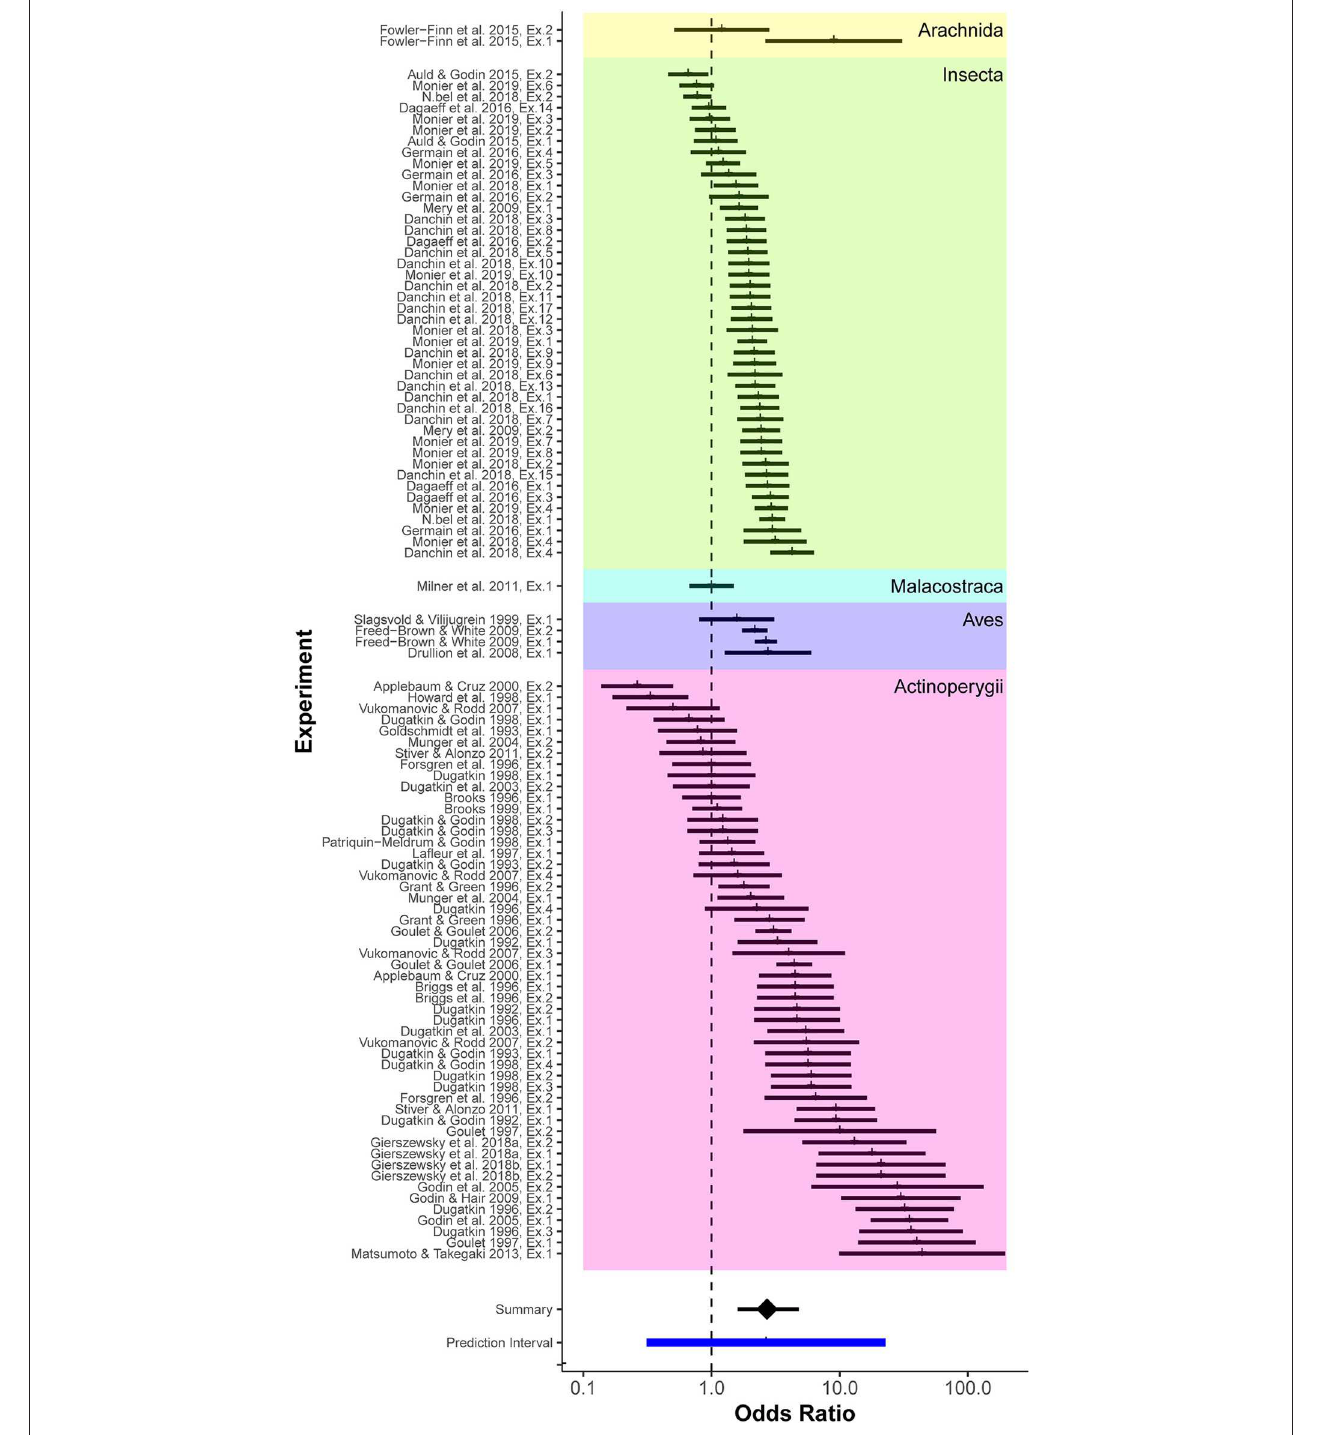
FIGURE 2 | Forest plot of effect sizes (odds ratios) from all considered studies, grouped taxonomically. Colored groupings represent taxonomic divisions by class. From top to bottom these are: Arachnida, Insecta, Malacostraca, Aves, and Actinoperygii. Effect sizes for individual experiments are indicated as vertical tick marks along with associated sampling errors (horizontal bar). The overall posterior mean effect size, derived from the mixed-effects model that accounted for phylogenetic distance, species, and study ( Table 1 ), was 2.71, indicating that an average female receiving positive social information about a prospective mate was 2.71 times more likely to mate with that male compared to females with no social